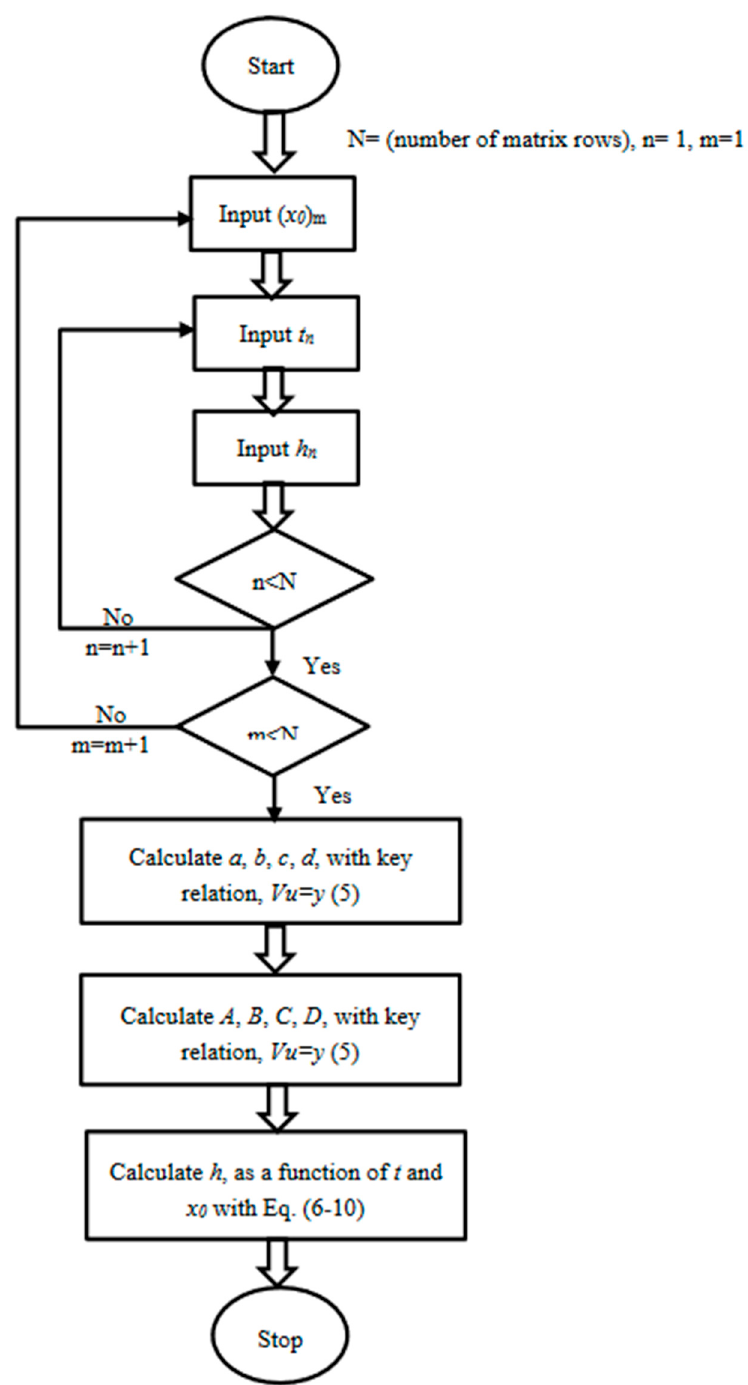
Figure 2. Algorithm used for tuning the coefficients associated with the VM-based model (Equations (6)–(10)).